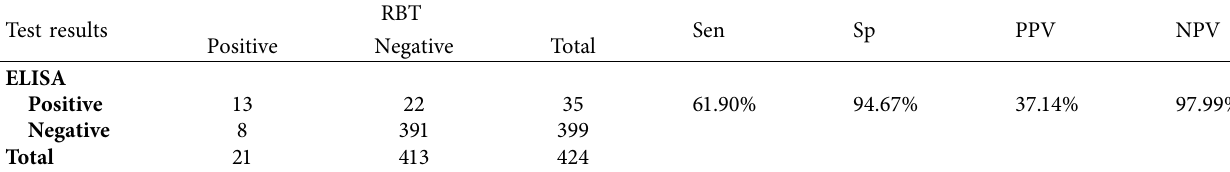
Table 3: Sensitivity and specifcity of the ELISA as shown by the RBT.